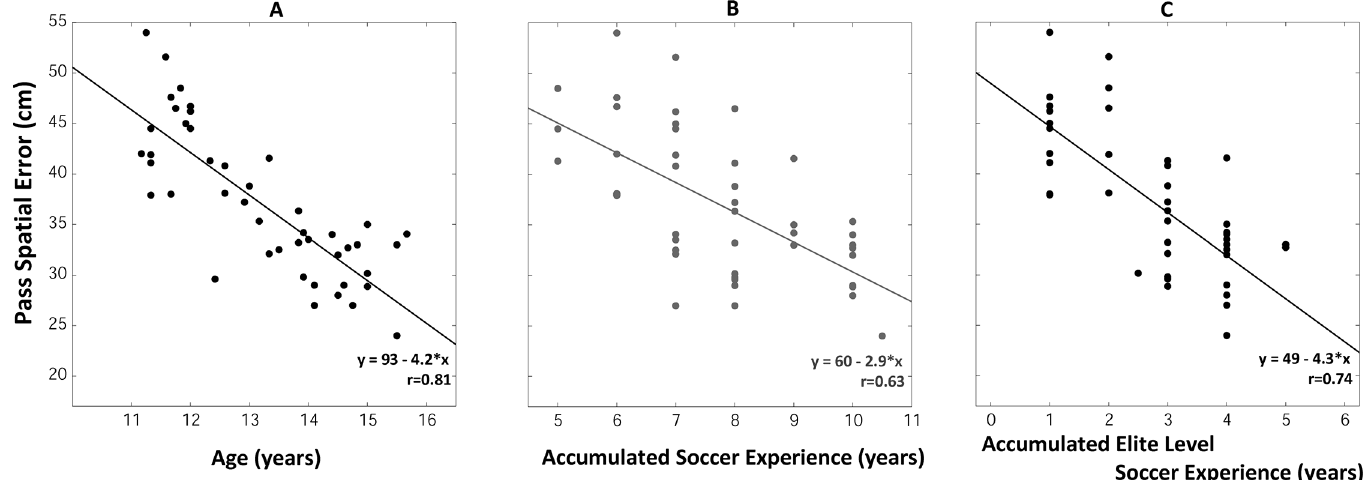
Fig 2. Passing spatial error of elite young soccer players as a function of age (A), accumulatedsoccer experience (B) and elite level-soccerexperience (C).